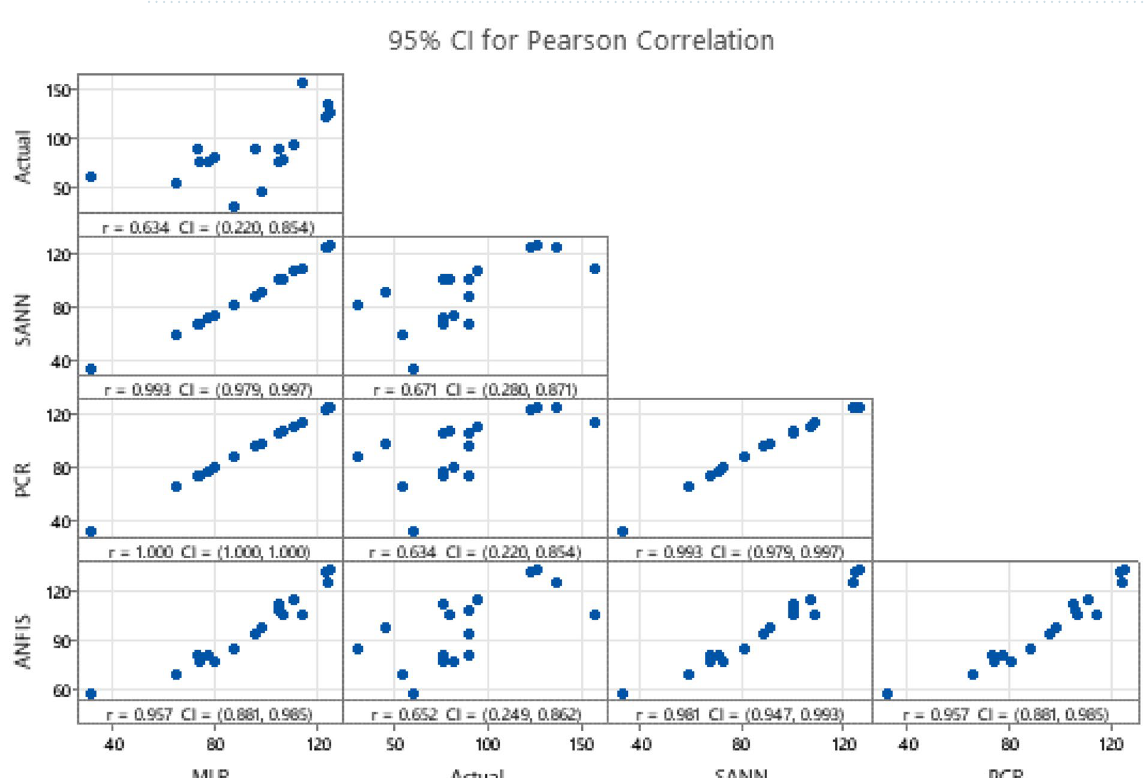
Figure 11. 95% percent confidence interval for the correlations of the actual and the predicted